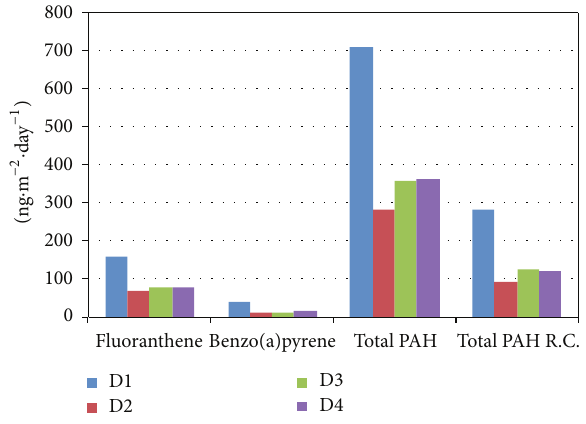
Figure 5: Fluxes of vanadium, lead, and arsenic and precipitations in D4 from August 2005 to March